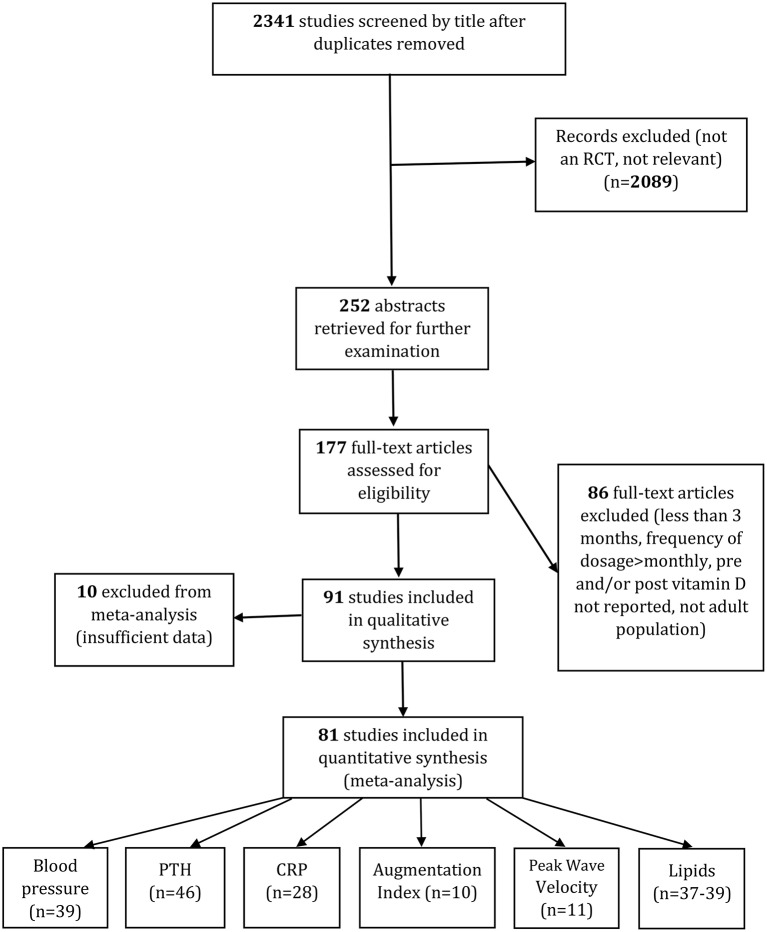
PRISMA diagram of study selection.